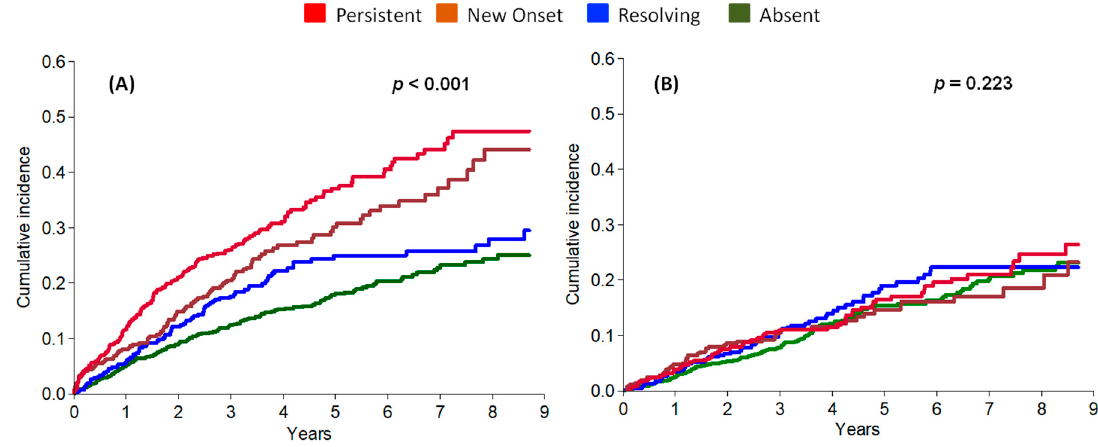
Figure 4. Cumulative incidence after visit 2 of ESKD ( A ) and all-cause death before ESKD ( B ), by competing risk analysis, by hyperkalaemia category.